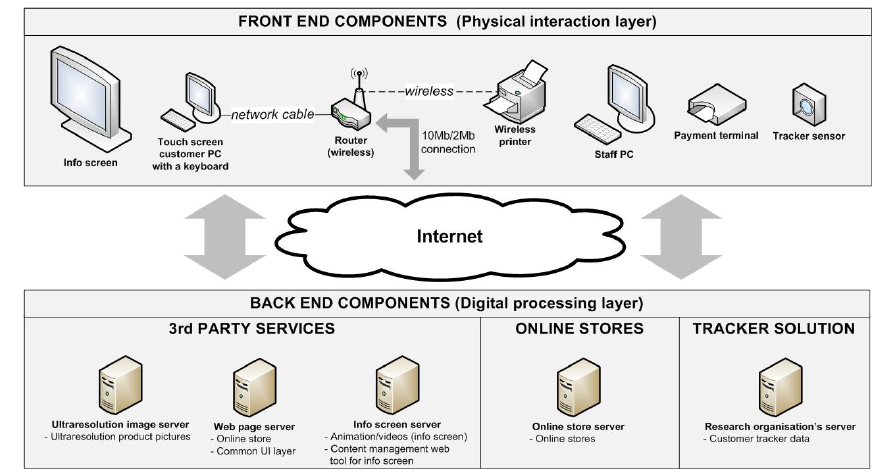
Fig. 5. IT based tangible digital components (resources) constituting a digital infrastructure of the shopping service